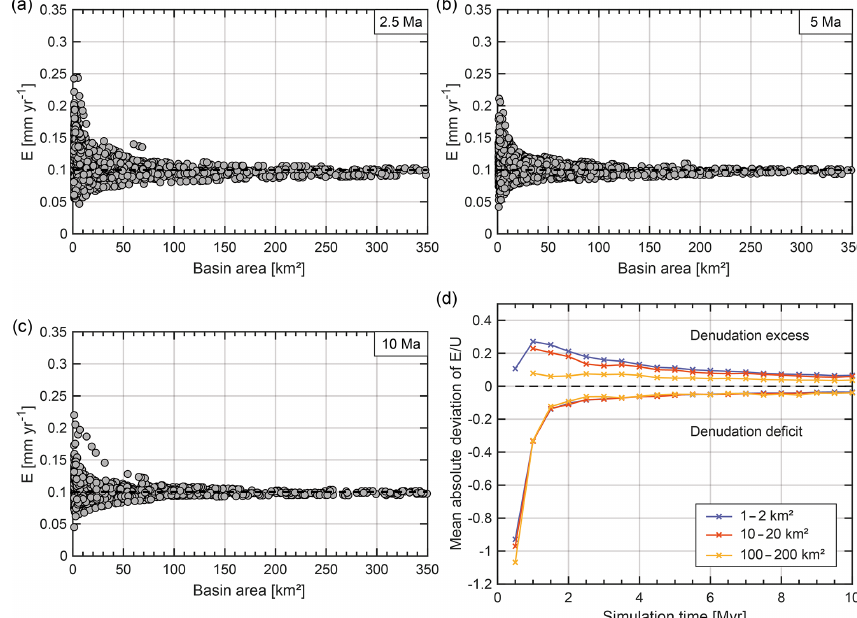
Figure 5. Variability of denudation rates over time for a compilation of five simulations of the reference model with different initial noised DEM. (a–c) Variability of denudation rate as a function of basin area after 2.5, 5 and 10Myr of simulation, respectively. (d) Mean absolute deviation (MAD) from uplift rate (0.1mmyr − 1 ) for three classes of basin sizes: 1–2, 10–20 and 100–200km 2 between 0.5 and 10Ma. Negative (positive) deviation is related to deficit (excess) of